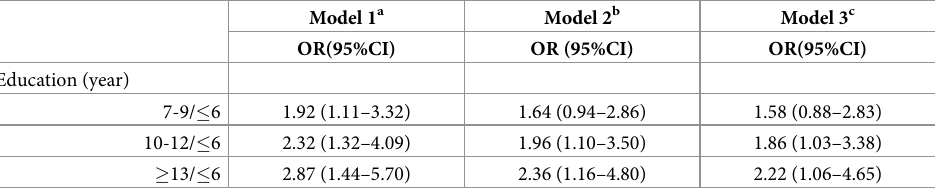
Table 5. The ORs for breast cancer prevalence by education level.